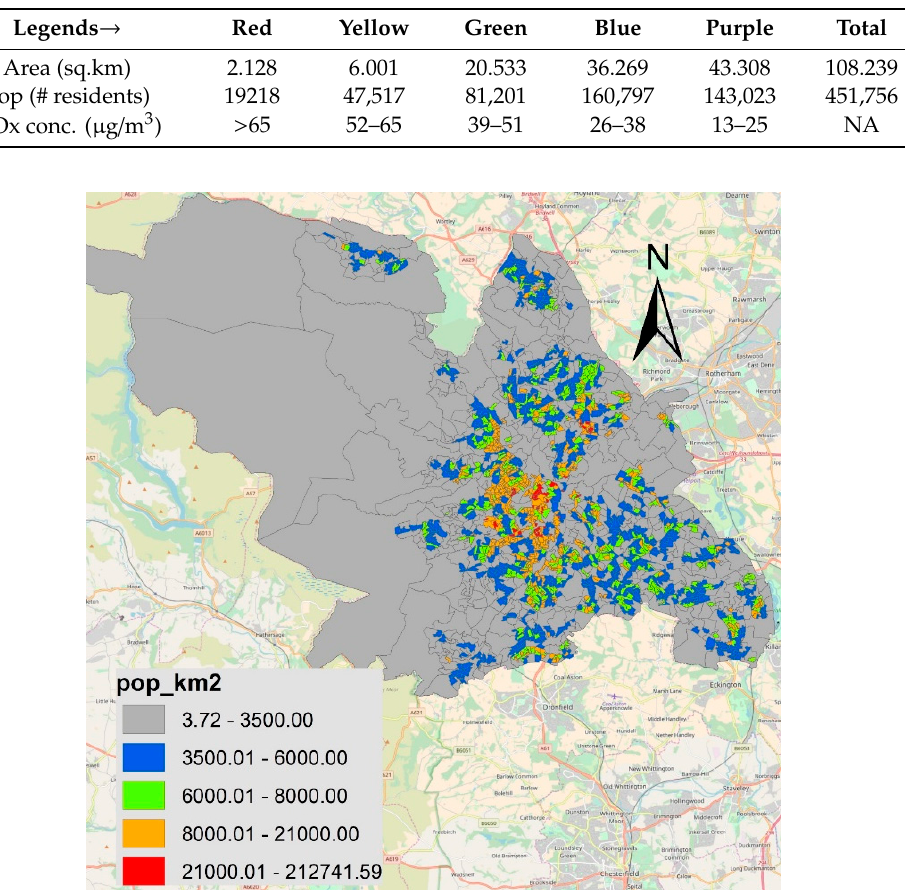
Figure 12. Population density (residents/km 2 ) map of Sheffield, 2016.